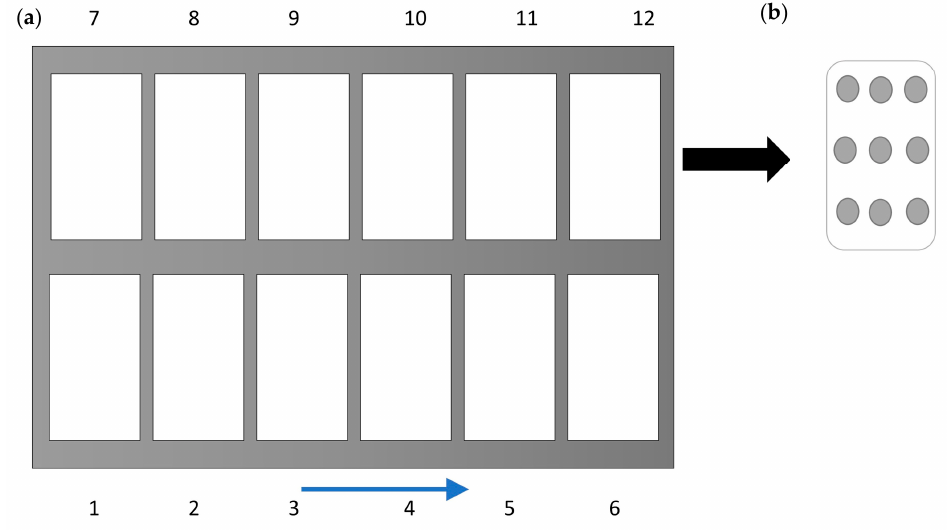
Figure 3. Tray configuration for colorimetric analysis ( a ), where the numbers indicate their position in the processing tray and the arrow indicates the direction toward the waveguide. Division of each tray into nine regions for measuring L values ( b ).